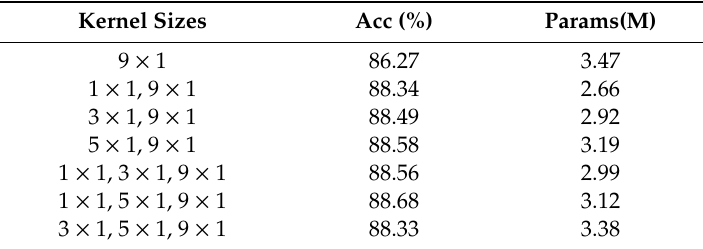
Table 1. Action recognition accuracies by ETGCN which use multiple temporal convolution kernels with di ff erent sizes.